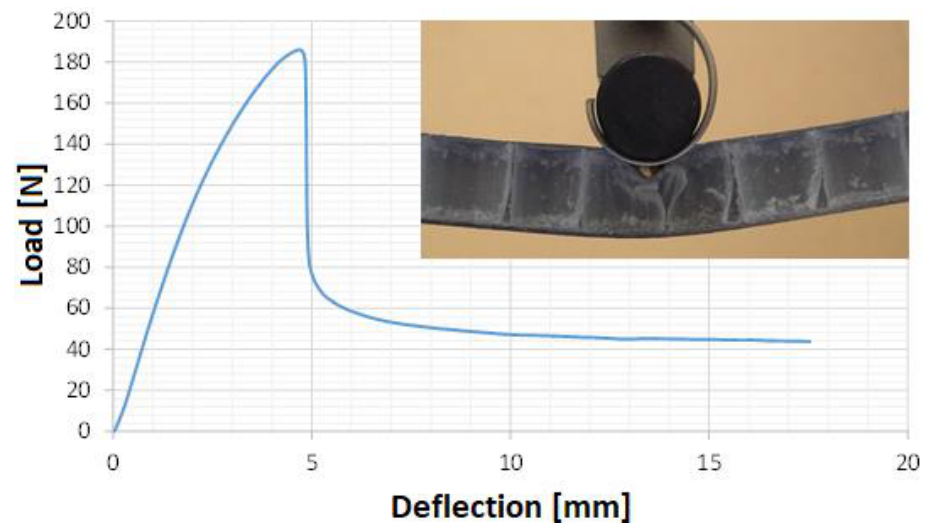
Figure 7. Load vs. mid-span deflection measured during sample c1 testing. In the upper right corner shows the structure failure.